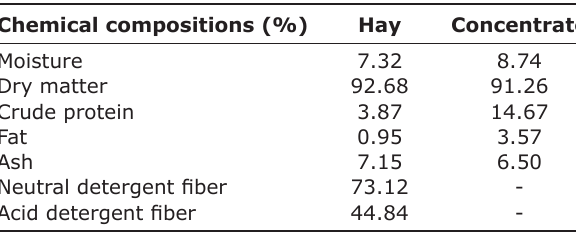
Table-1: Chemical compositions of the feed component (% on dry matter